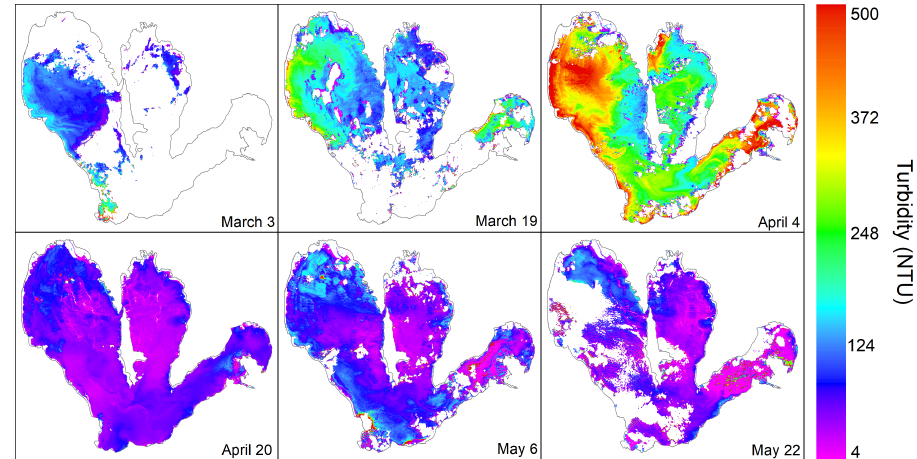
Figure 6. Turbidity maps of Laguna de Bay during the dry season of 2017. Note that the areas without turbidity retrieval correspond to cloud-covered pixels.